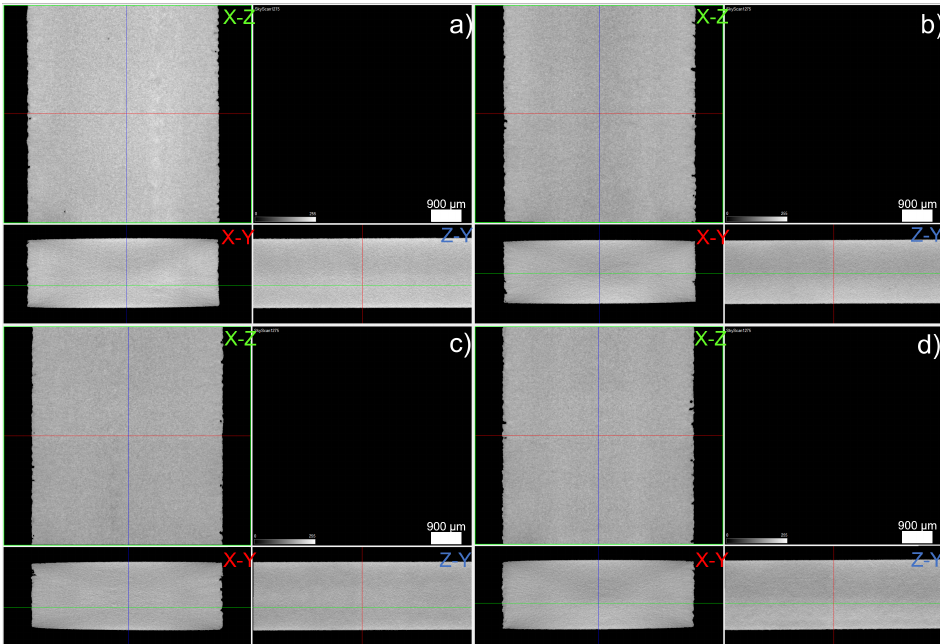
Figure 5. 2D visualization of the pores location in cross-section for 316L ( a ), 630 ( b ), 420 ( c ) and 440C ( d